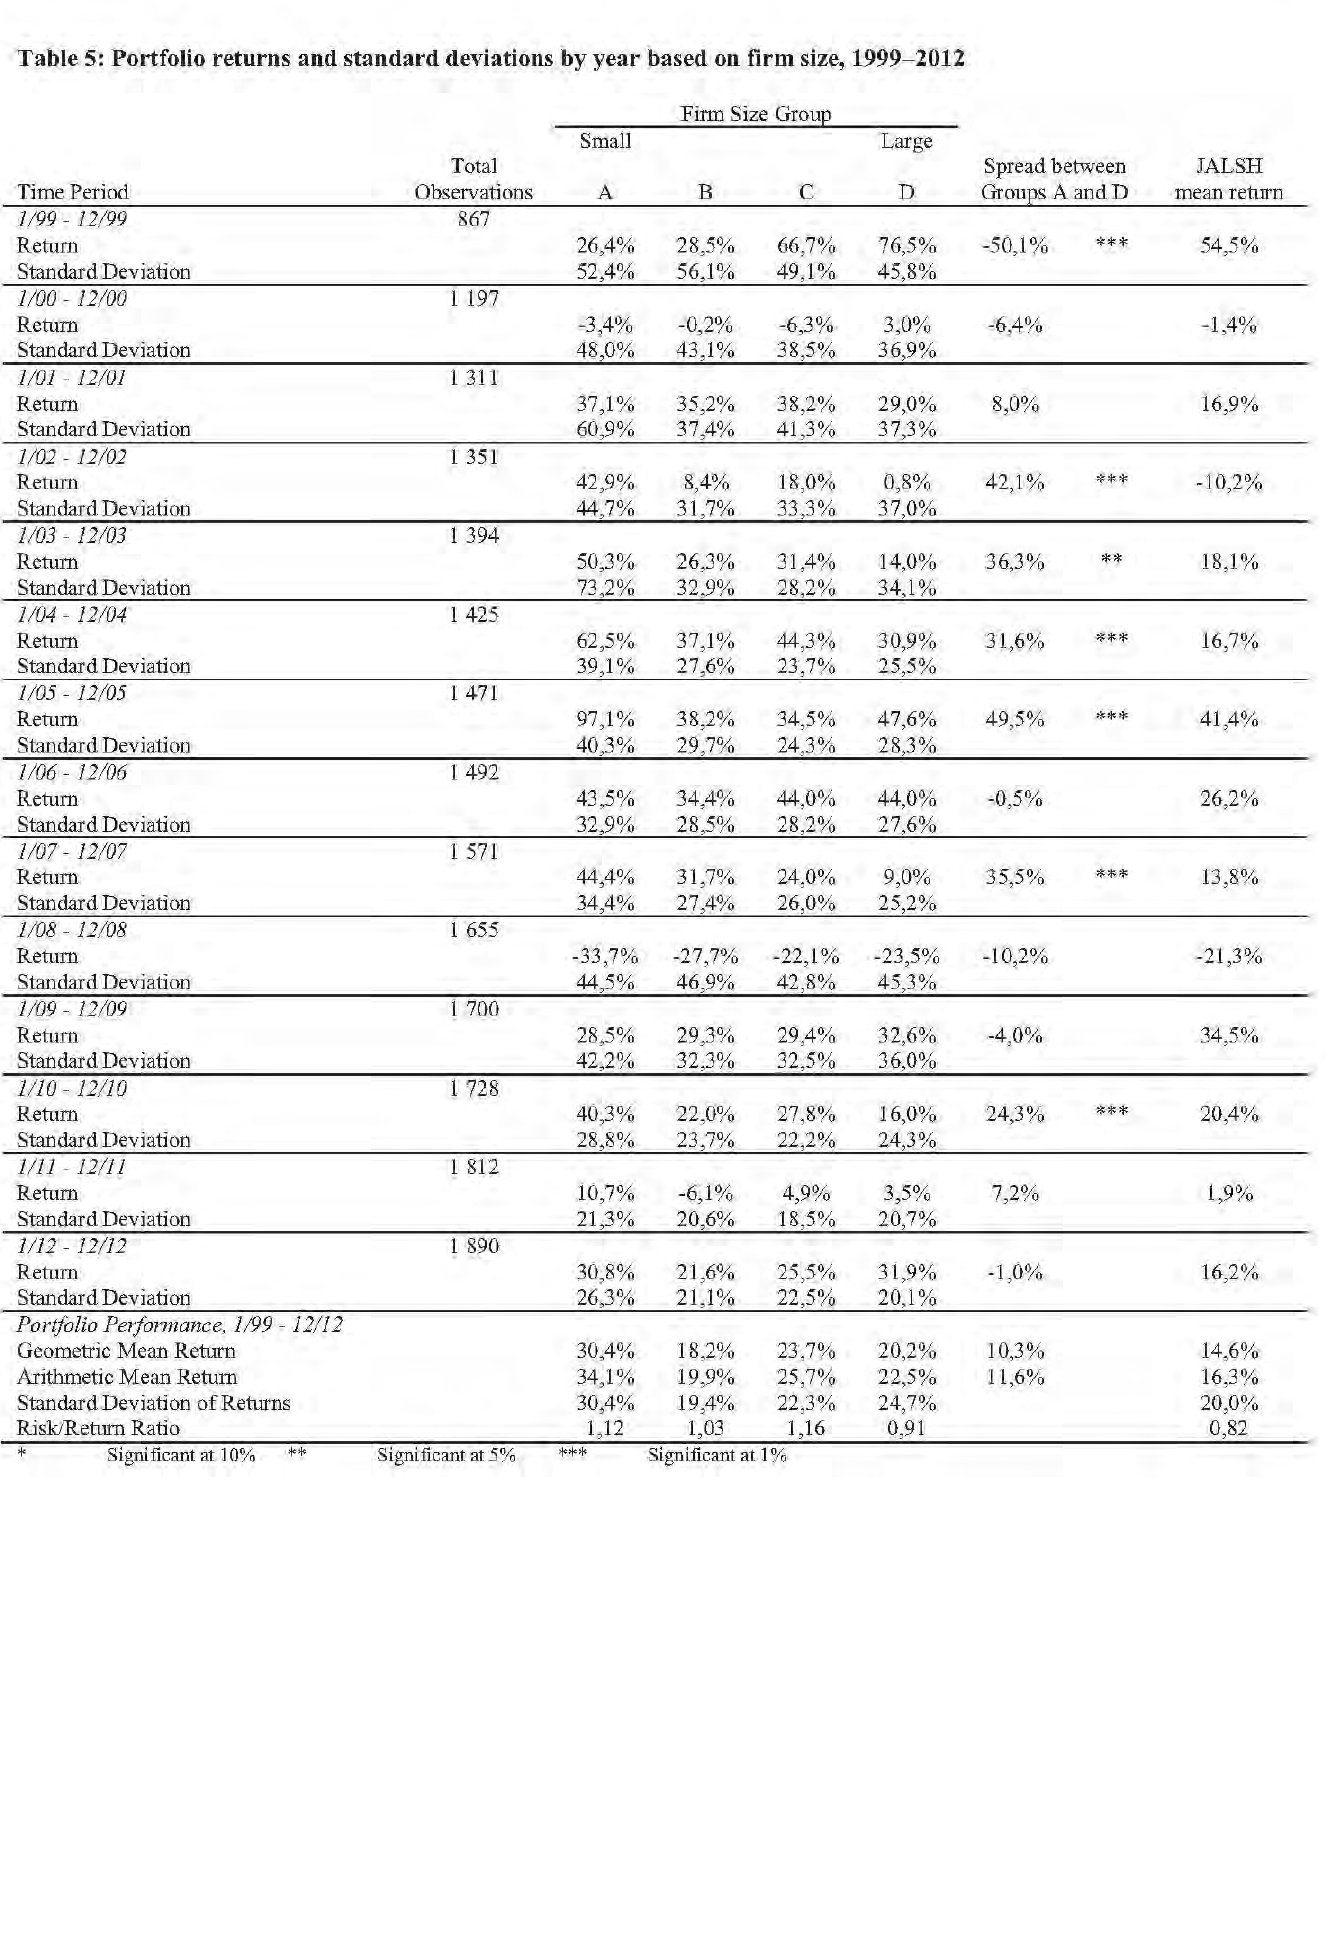
Firm Size GrouE Small Large Spread